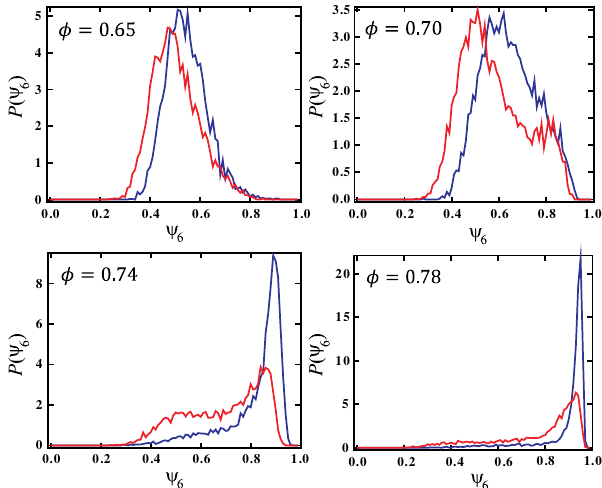
FIG. 6. ϕ dependence of the probability distribution function of the hexatic order parameter ψ 6 , P ð ψ 6 Þ , at Γ ¼ 3 . 3 . Blue curves are for a steel ball system, whereas red curves are for a rubber ball system. For a steel ball system, P ð ψ Þ always has a unimodal shape, whereas for a rubber ball system it has a clear bimodal shape for ϕ between ϕ and ϕ . The long tails of P ð ψ 6 Þ toward L S low ψ 6 in homogeneous solid phases come from defects.